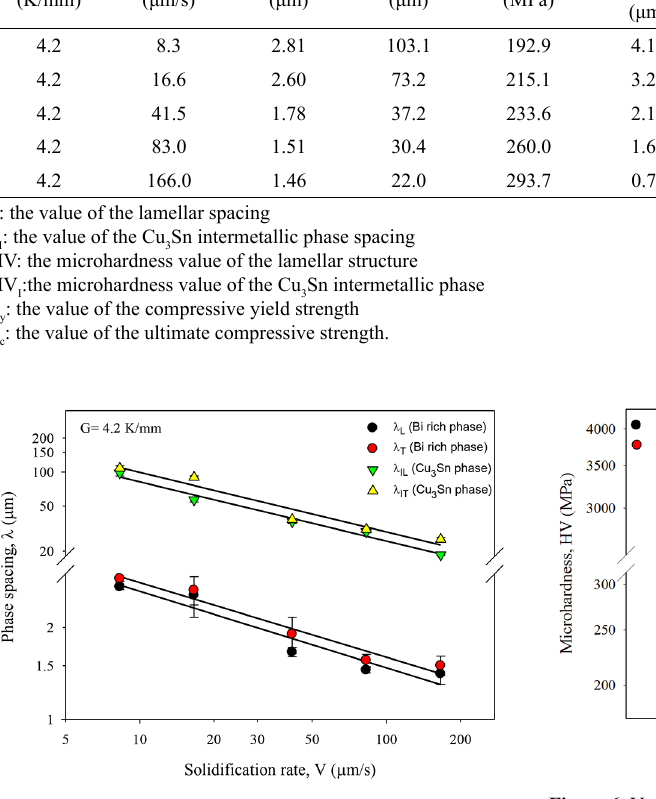
Figure 6. Variation of microhardness versus solidification rate